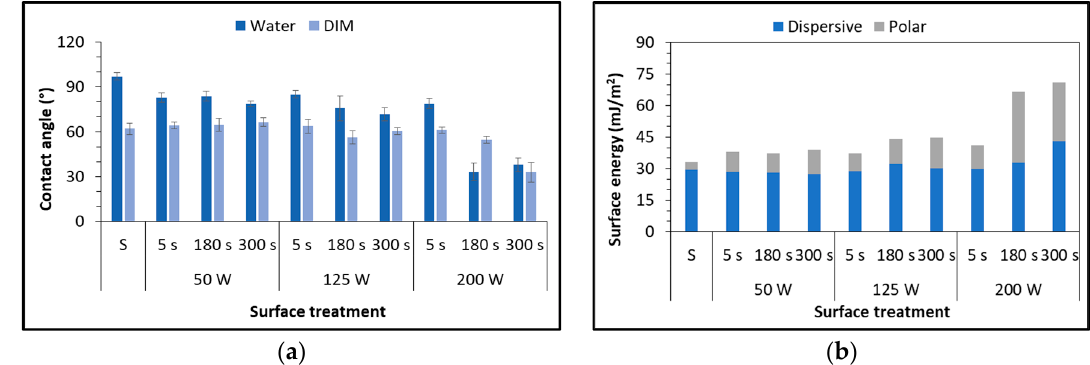
Figure 2. Static water and diiodomethane (DIM) contact angle ( a ) and surface free energy ( b ) of PP substrates as a function of plasma parameters, using air as working gas.